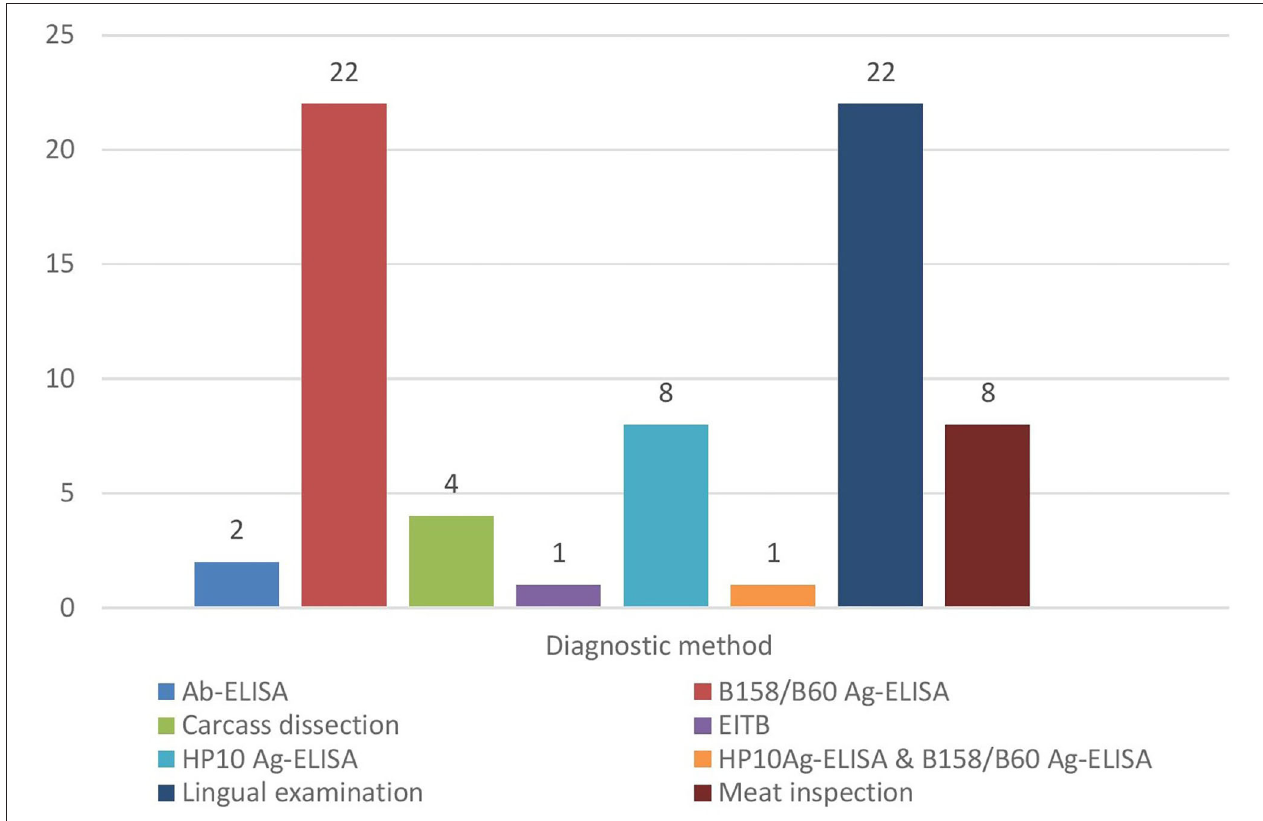
FIGURE 2 | Type of diagnostic techniques employed in the reviewed